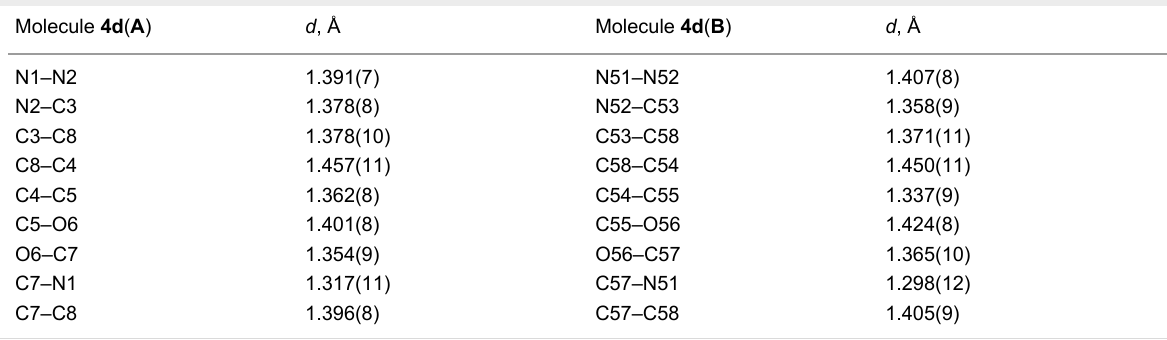
Table 2: Selected bond lengths of the 2 H -furo[2,3- c ]pyrazole core.